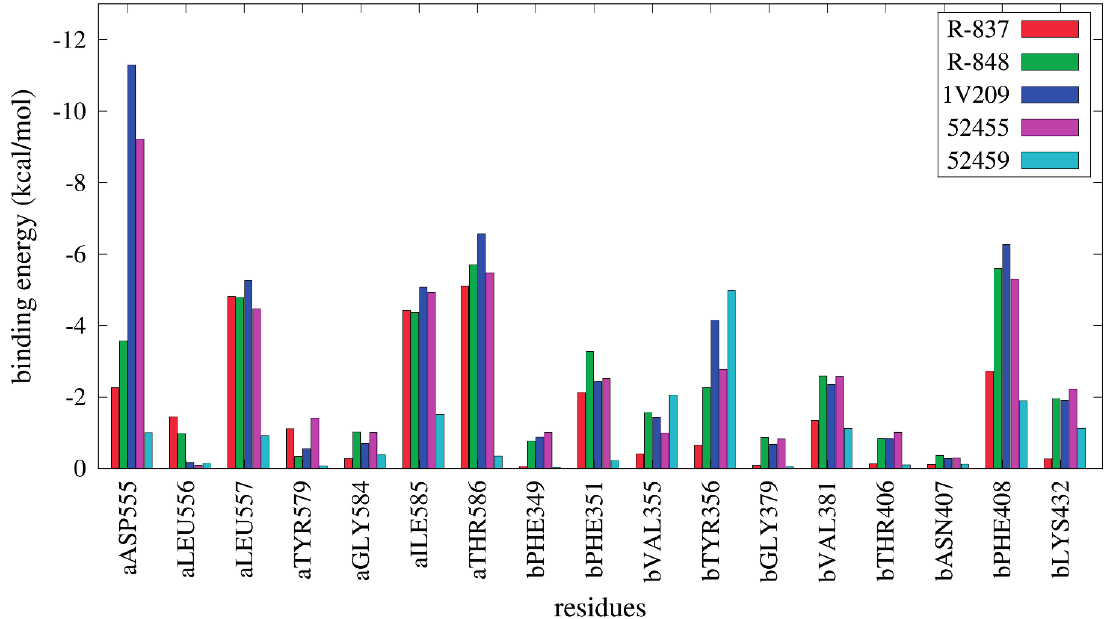
Figure 9. Pairwise per-residue decomposition of binding energies for selected agonists and one inactive compound. a and b residue suffixes refer to the relative TLR7